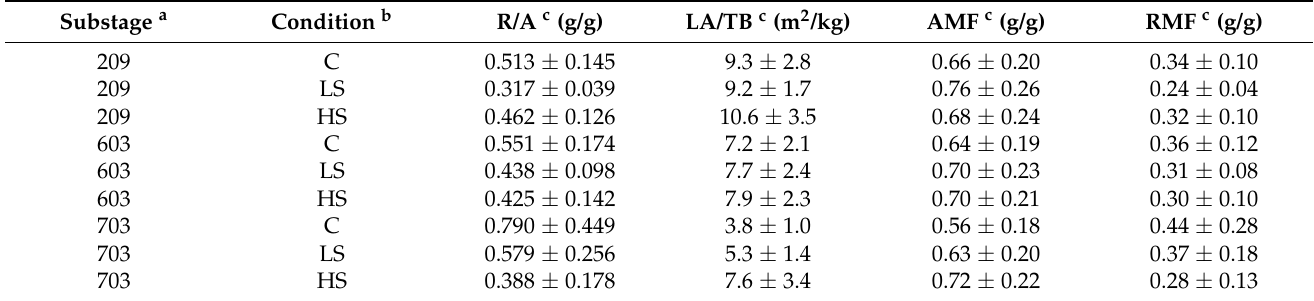
Table 2. Growth parameters-derived indices for P. peruviana plants along growth substages under salinized conditions. Substage a Condition